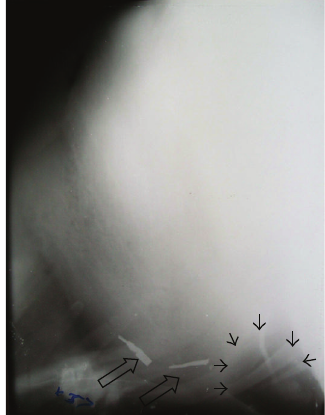
Figure 3: Lateral radiograph of reticulum showing unclear diaphragmatic line and a sac-like structure (arrows) of soft tissue density cranial to diaphragm.